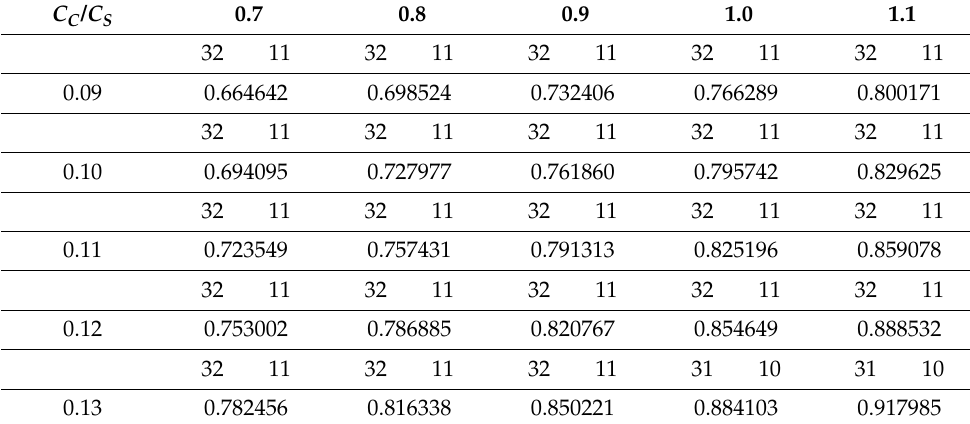
Figure 4. TC (32,11) vs. µ , H = 8; β = 0.95; N = 5; C C = 0.1; C S = 0.8; C B = 0.07; C P = 0.05; C R = 0.1; C W = 0.1. Table 4. Impact of C C and C S costs on the optimal value.